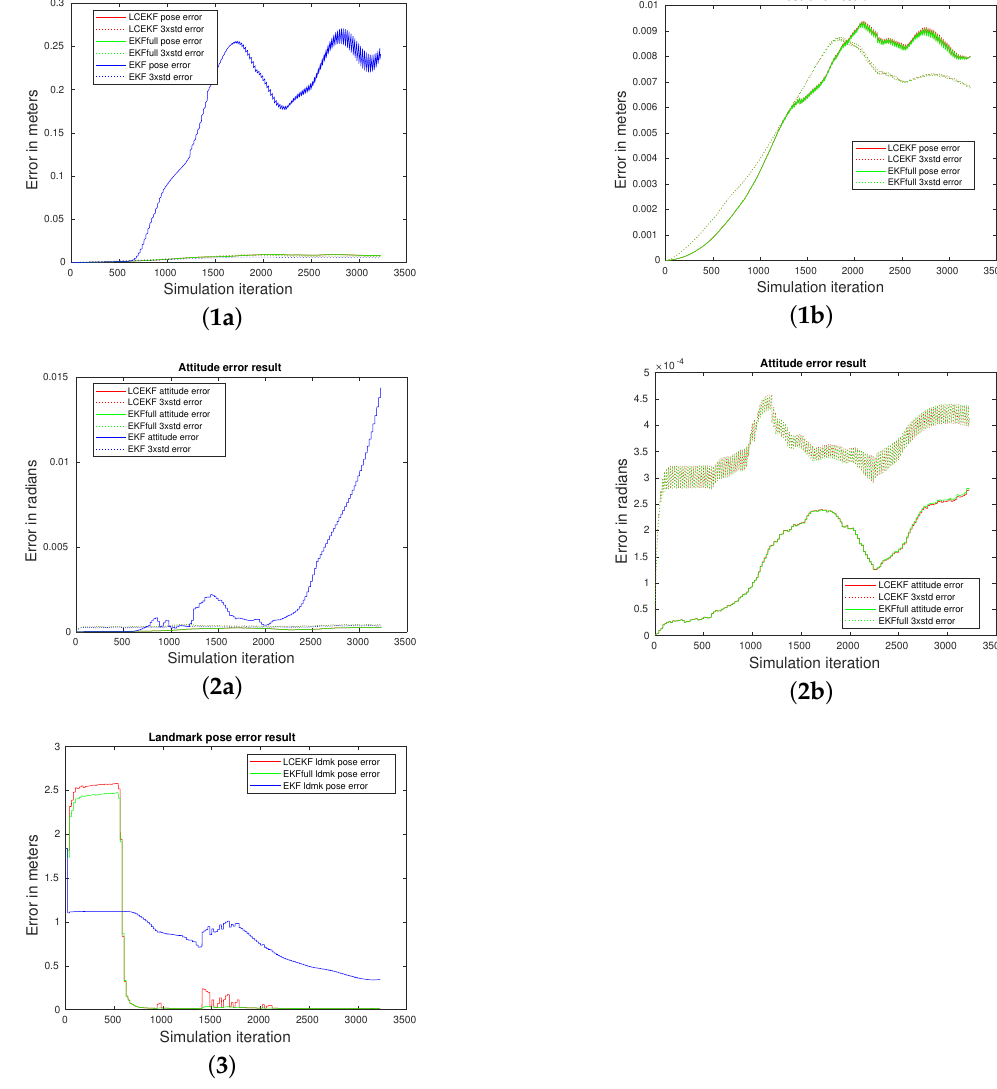
Figure 6. SLAM with constant noise (Case ii): methods’ comparison. Figures ( 1a ) and ( 2a ) represent the MSE of the pose and attitude estimation over 100 executions for the three methods. As the EKF results hide the two other, the same results without the EKF are presented in Figures ( 1b ) and ( 2b ). Full lines are the mean of the estimation, and dotted lines represent the 3 sigma value. Figure ( 3 ) represents the MSE of the landmark convergence during the